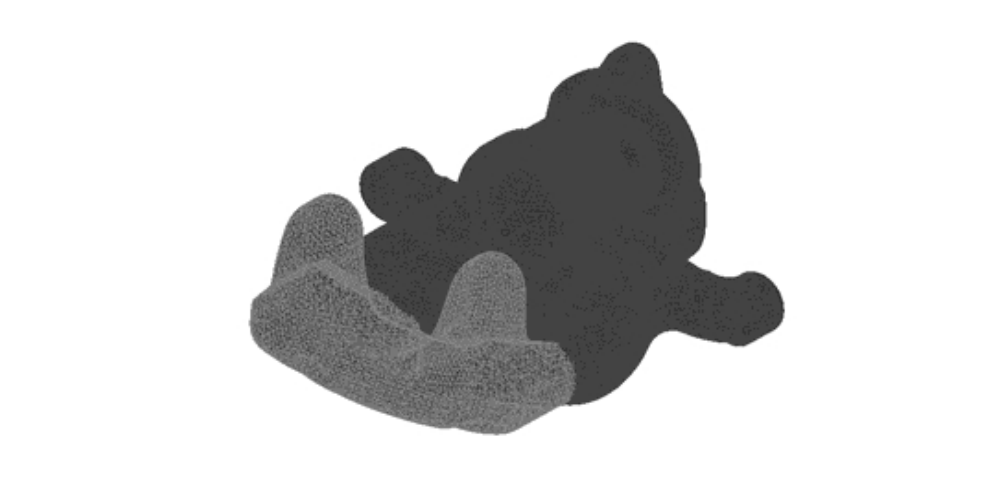
Fig. 8. Location of the caliper porosity volumes.